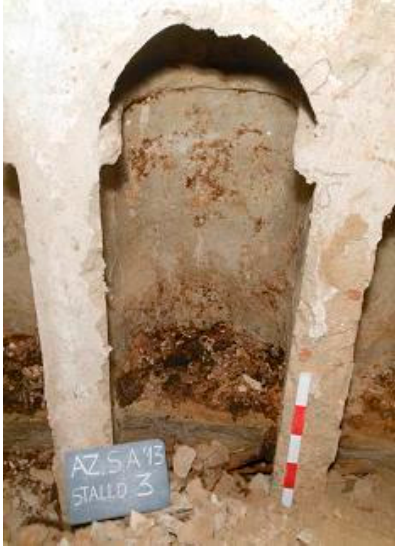
Figure 1. Burial niche (n.3) of the Crypt.